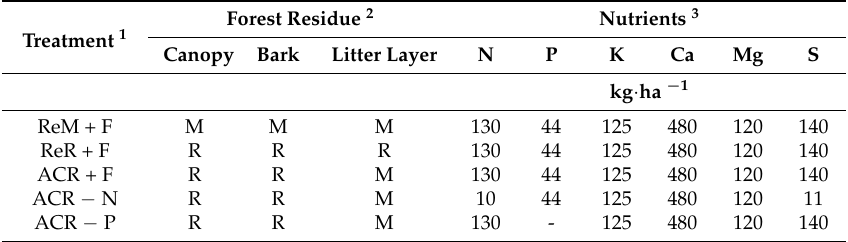
Table 2. Forest residue management and nutrients applied in